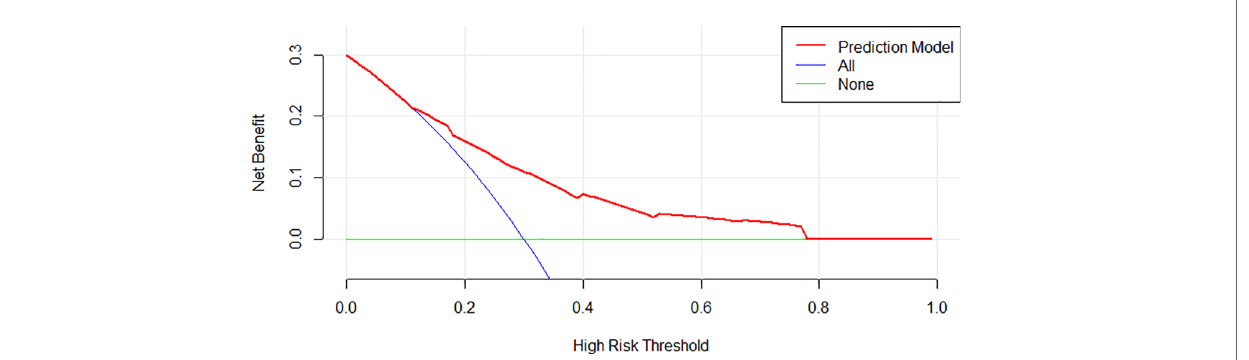
FIGURE 4 | Decision curve analysis for IRMM. The y-axis measures net bene fi t. The red line represents IRMM. The green line represents the assumption that all patients have an